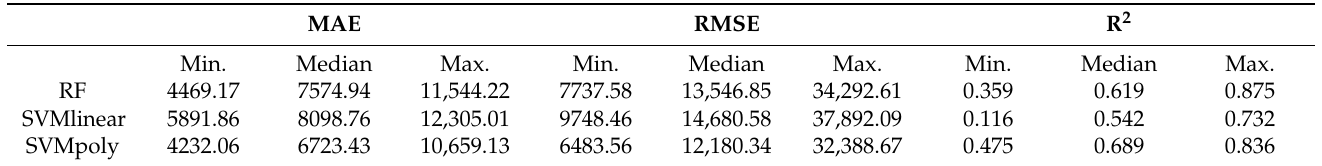
Figure 3. Result of the RF, SVMlinear and SVMpoly models. Table 1. Error metrics from the RF, SVMlinear and SVMpoly